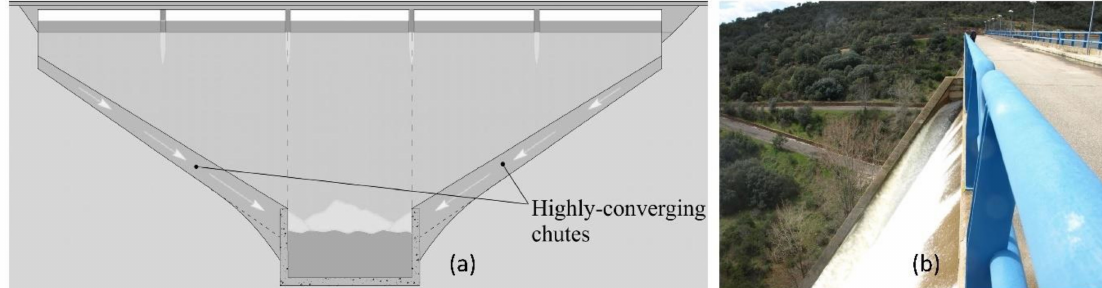
Figure 1. ( a ) Scheme of the HCCs of a gravity dam from downstream [13]. ( b ) View of one of the HCCs of Torre de Abraham Dam (Spain) in operation (courtesy of Jos é R. Gonz á